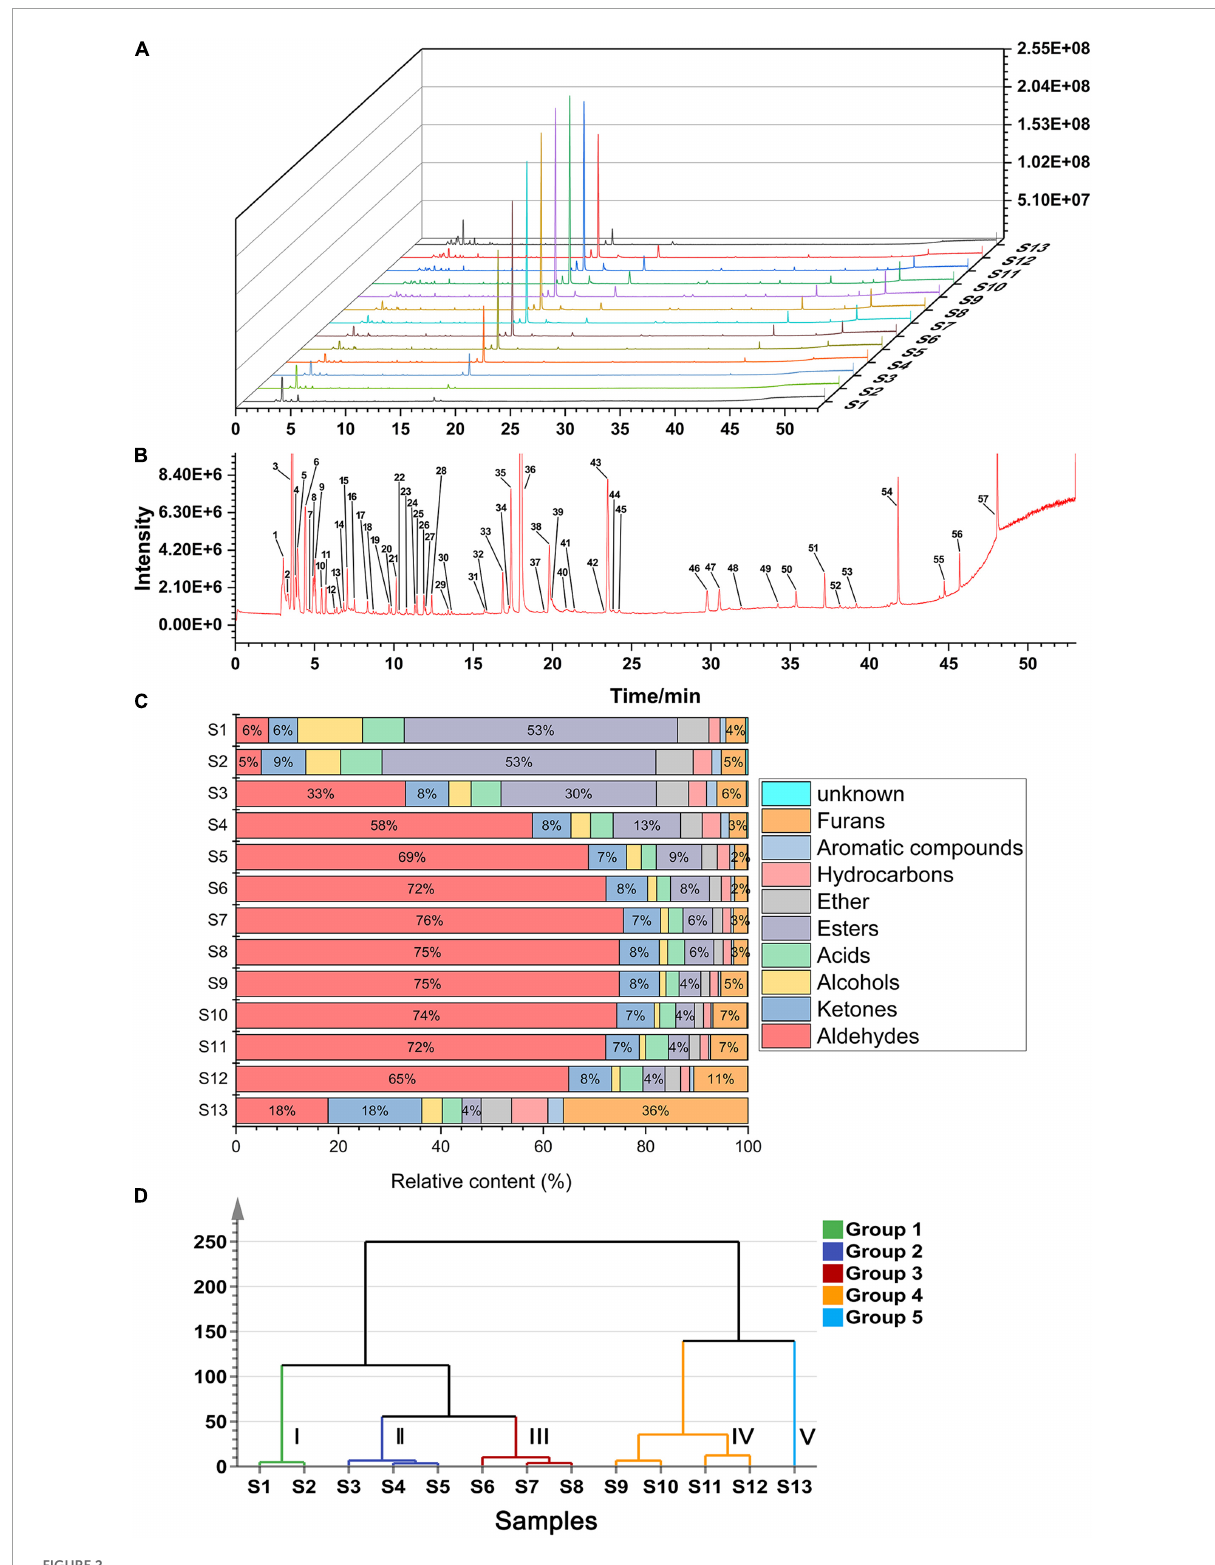
FIGURE2 Analytical plots of CF samples in roasting process by HS-GC-MS. (A) Overlays of TICs of CF by HS-GC-MS; (B) typical TIC and distribution of volatile compounds in CF; (C) percentage chart of all kinds of volatile substances in CF; (D) HCA plot of CF by HS-GC-MS.